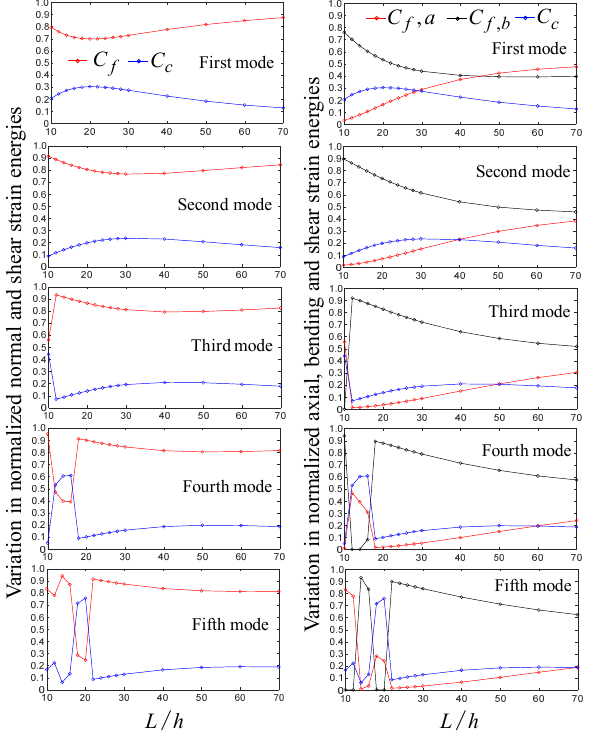
Figure 5. Variation in the strain energies on the natural frequencies of three ‐ layered beams with the C ‐ P end condition.